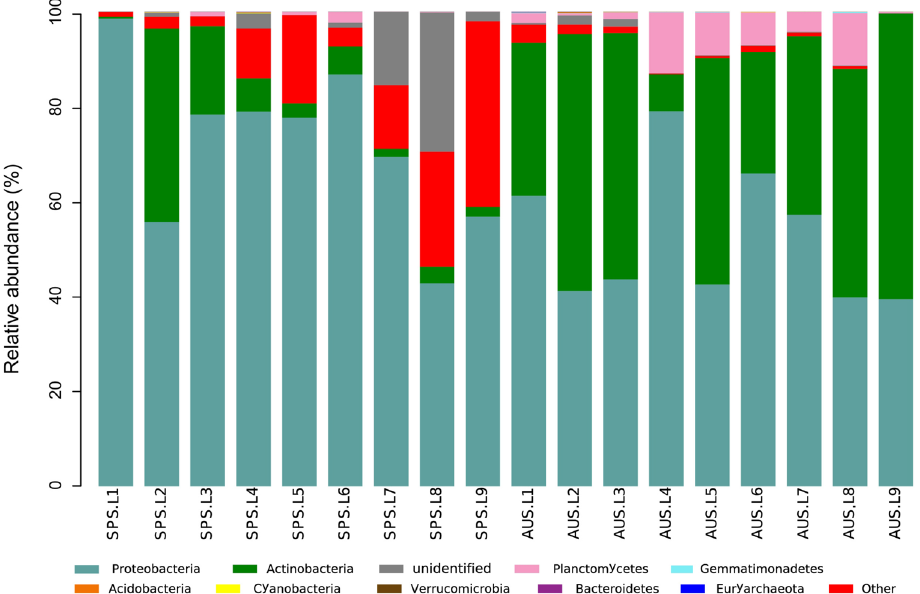
Figure 3. Relative abundance and composition of phoD -harboring bacterial phyla detected in the sediments of Sancha Lake in the spring and autumn. SPS Spring Location, AUS Autumn